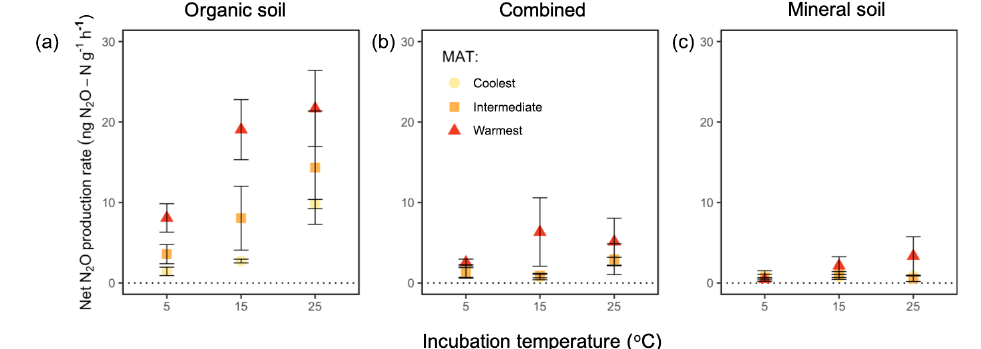
Figure 3. Net N 2 O flux (“production rate”) averaged for 60h of incubation at 5, 15, and 25 ◦ C from organic soil alone (a) , combined organic and mineral soil (b) , and mineral soil alone (c) from three regions along a boreal forest latitudinal transect. “Combined” refers to incubations with organic and mineral soil in the same jar, which are physically isolated but share the headspace. “MAT” refers to the mean annual temperature. The “coolest” region is the Eagle River watershed (northern boreal), the “intermediate” region is the Salmon River watershed (mid-boreal), and the “warmest” region is the Grand Codroy watershed (southern boreal). See the text for site descriptions. Values are provided as the mean ± 1SE ( n = 3 forests per latitudinal region).